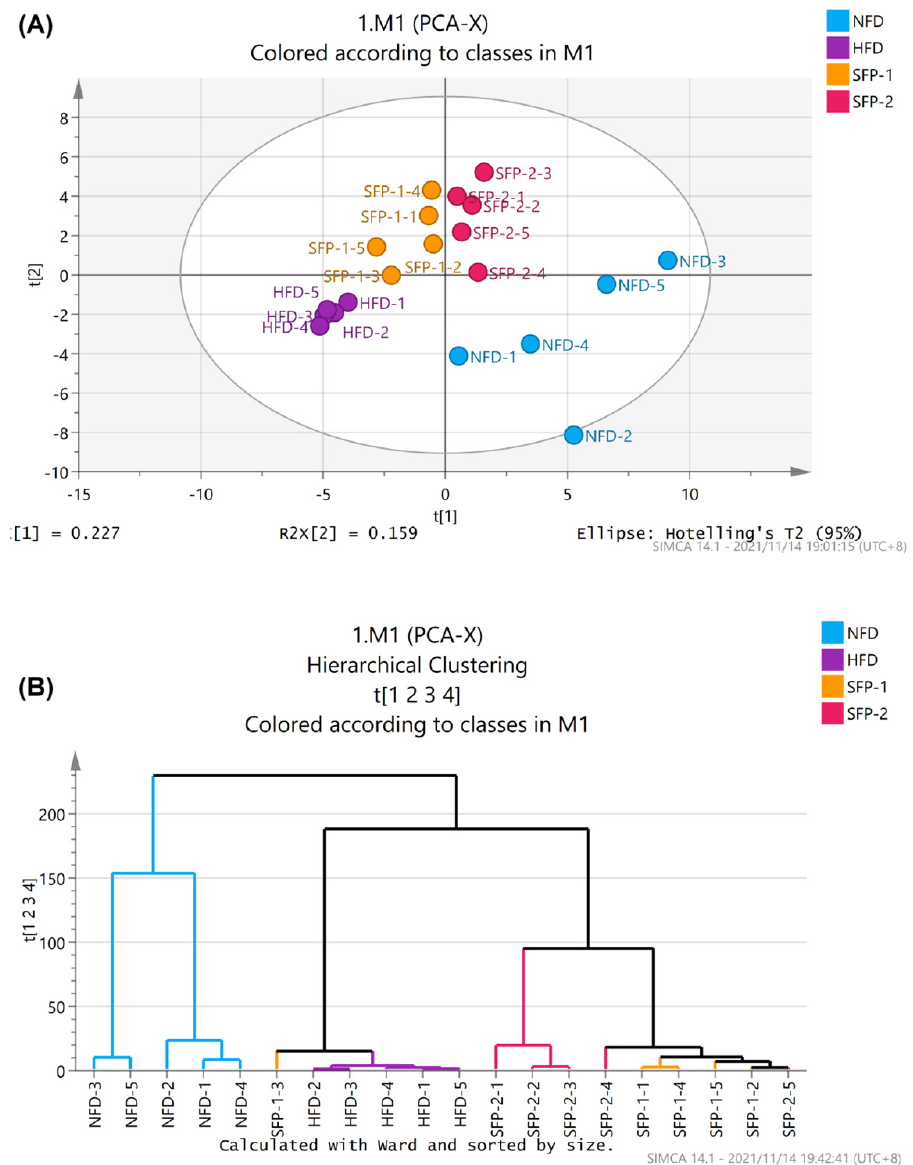
Figure 5. Effects of SFPs on gut microbiota in diabetic rats. Principal component analysis ( A ), hierarchical clustering tree analysis ( B ).